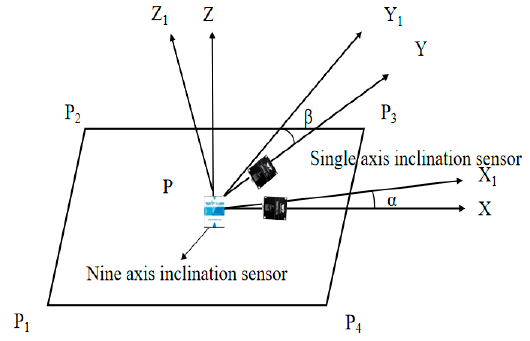
Figure 3. Rotation diagram of the mobile platform.